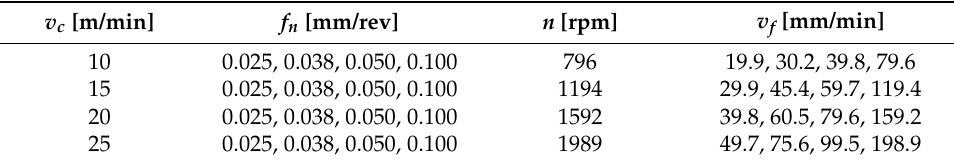
Table 2. Cutting conditions for the drilling